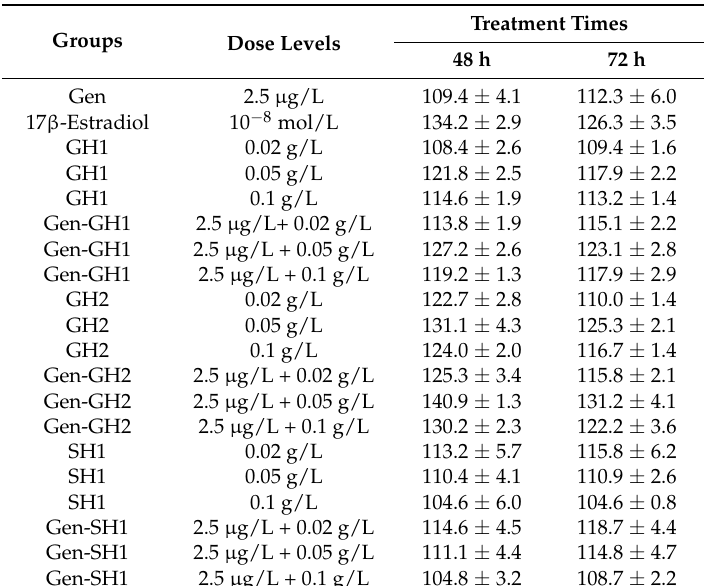
Table 2. Cell viability of the osteoblasts treated with genistein (Gen), protein hydrolysates, and Gen-hydrolysate combinations for 48 or 72